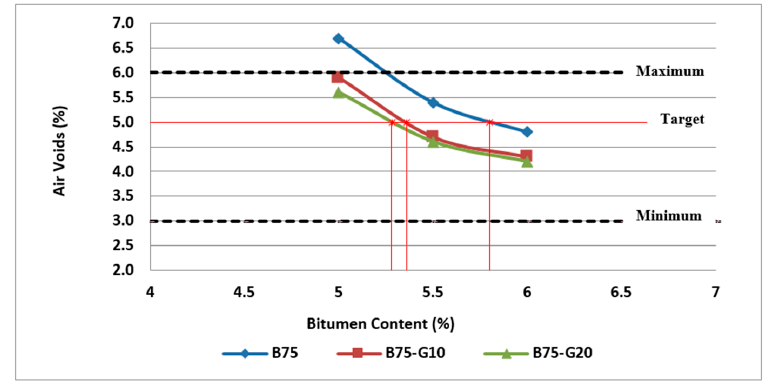
Figure 10. Effect of bitumen content and glass content on air voids of Mix II containing 25% RCA without glass and Mix IV and Mix V containing 25% RCA as coarse aggregate and glass as fine aggregate.